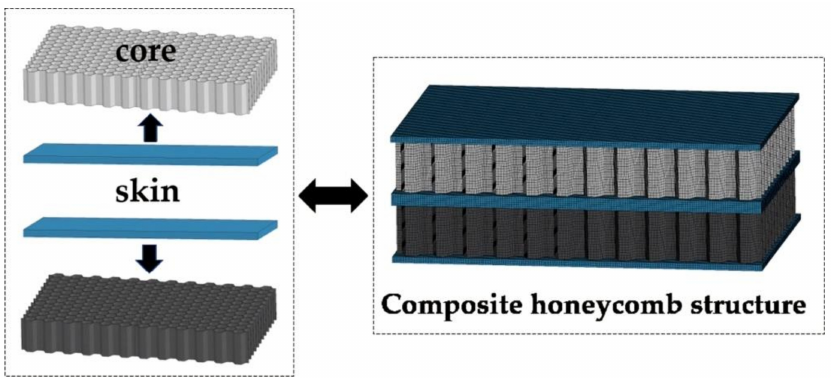
Figure 2. Finite element model of composite honeycomb